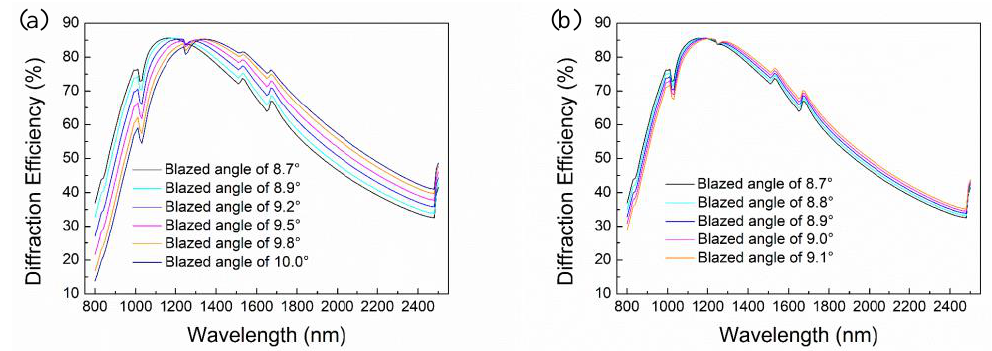
Figure 3. Diffraction efficiency of blazed gratings with blaze angle of ( a ) 8.7°, 8.9°, 9.2°, 9.5°, 9.8°, and 10.0°; ( b ) 8.7°, 8.8°, 8.9°, 9.0°, and 9.1°.